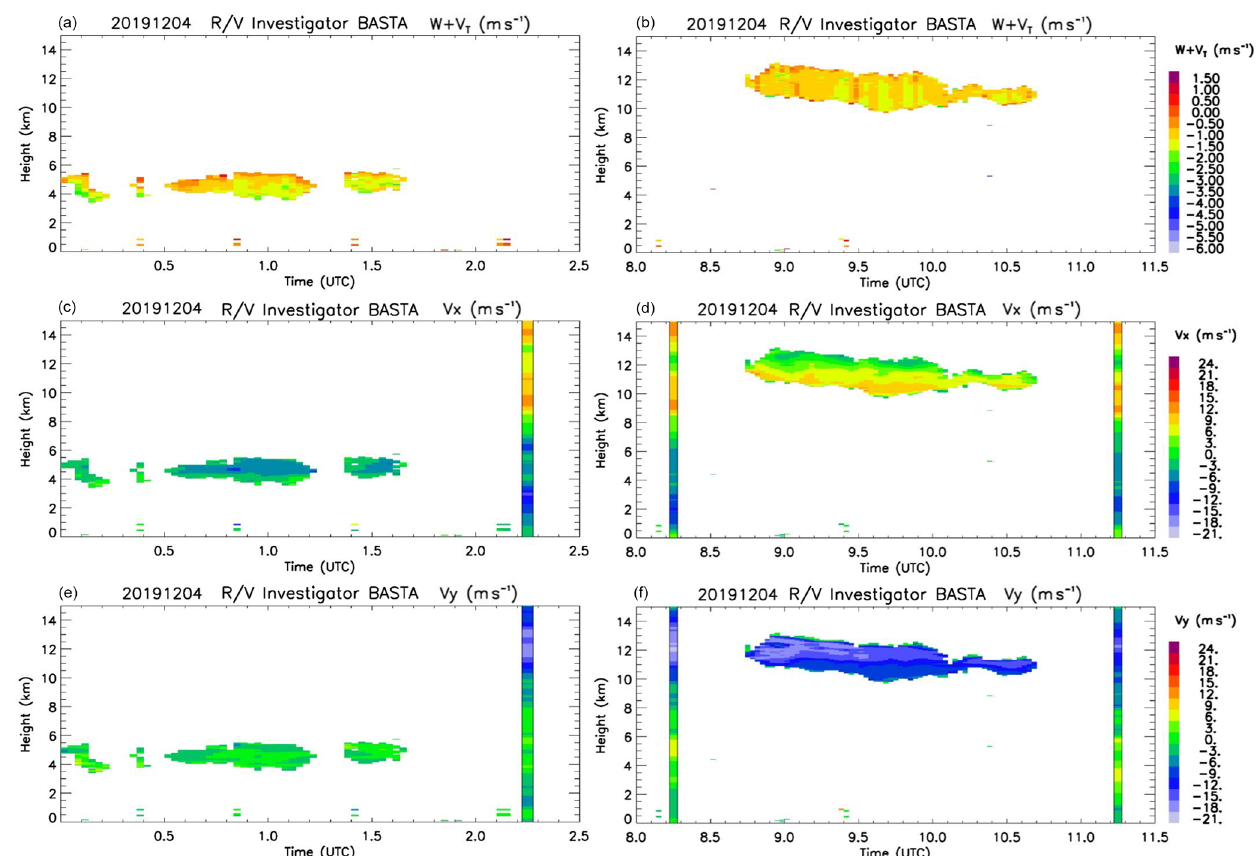
Figure 6. Same as Fig. 1 but for the (a, c, e) altostratus and (b, d, f) tropical cirrus cases sampled on 4 December 2019.